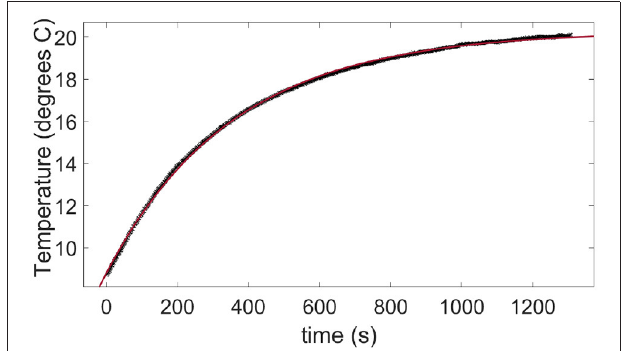
FIGURE A2 | Warming up in air at room temperature of a skin sample taken out from a refrigerator. The data points (crosses) are measured with the infrared camera. The plain line is a fit of Equation (B1) with a time constant τ a